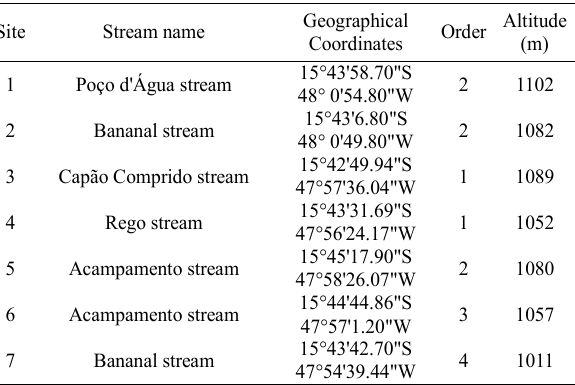
Table 1. Localization, altitude and streams order at the sampling sites (scale 1: 10.000) at the Bananal stream subbasin, Paranoá Lake basin,